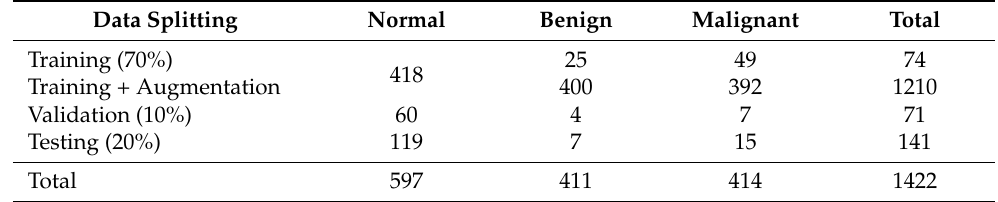
Table 3. INbreast data distribution of Approach B (multi-class classification) of each class. The number of augmented training breast images is listed in the second column of each